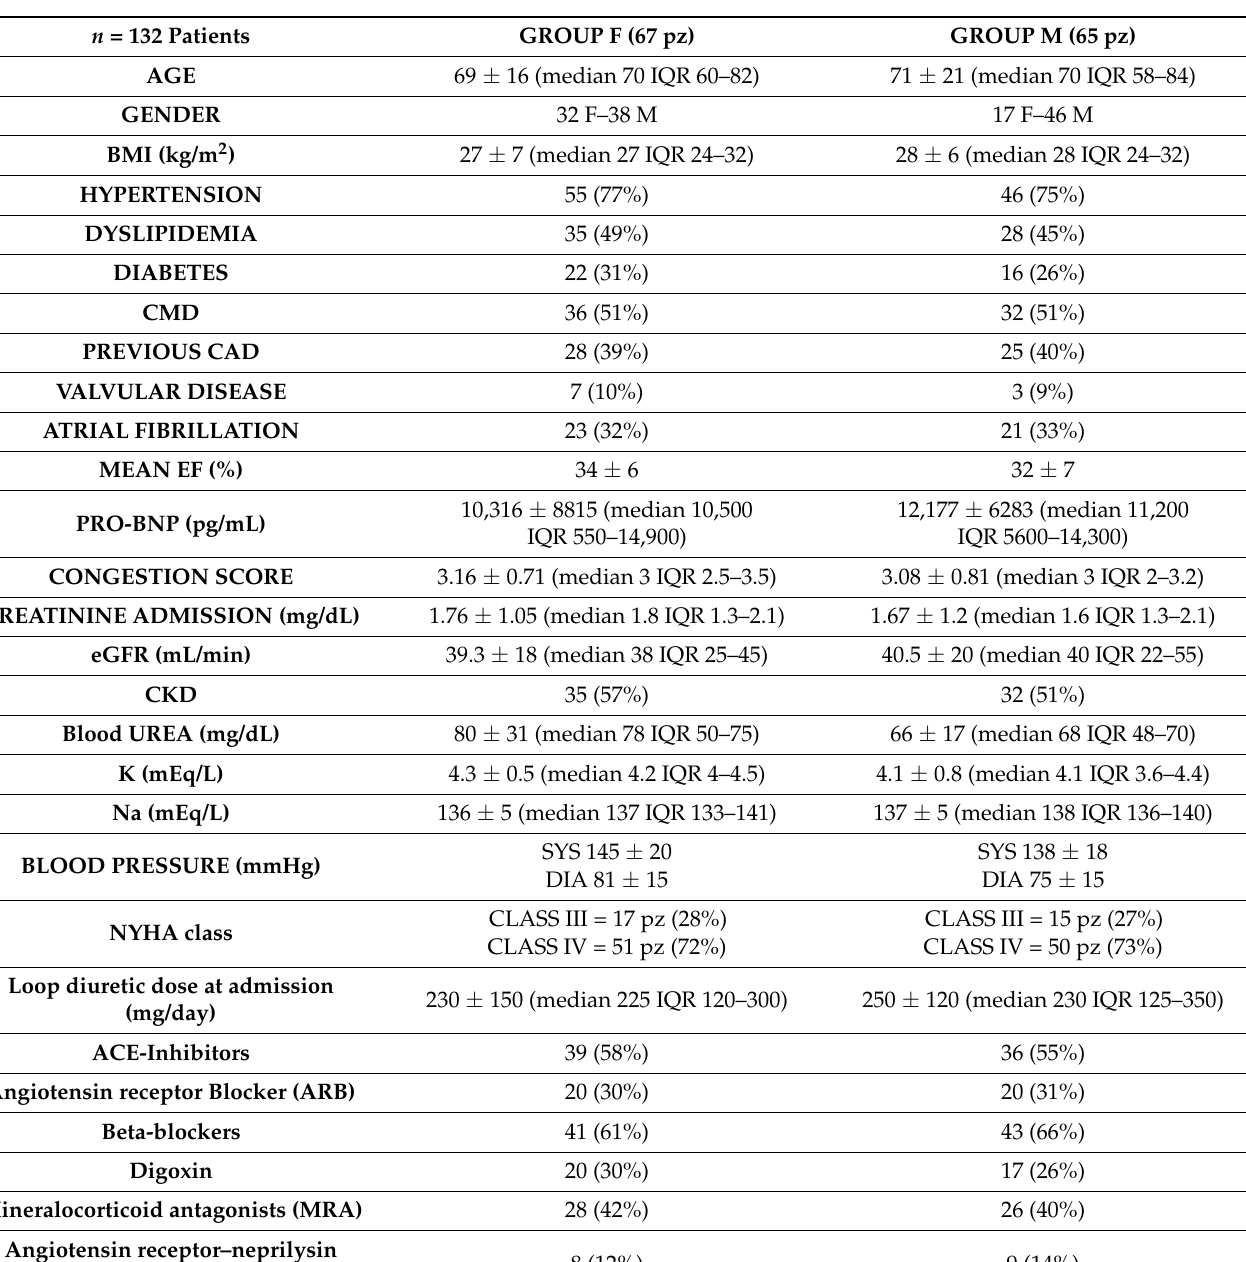
Table 1. General characteristics of enrolled population characterized by advanced NYHA class, high congestion score, and oral diuretic administration associated with poor diuretic